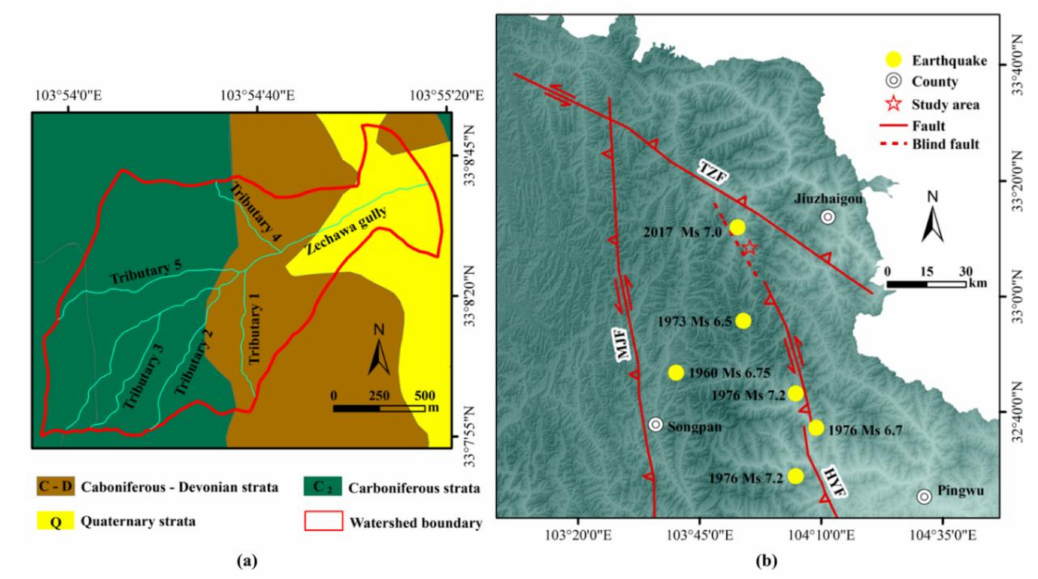
Figure 2. Study area maps. ( a ) Geologic map of the study area; ( b ) Topographic map of the Tazang fault (TZF), the Minjiang fault (MJF), the Huya fault (HYF) and the blind extension of the HYF (modified from Zhao et al.